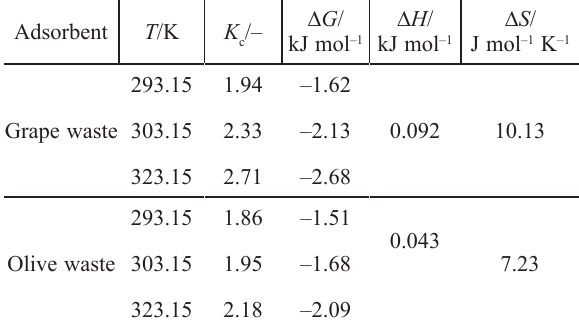
Table 4 – Thermodynamic parameters for the adsorption of Cr(VI) on grape and olive waste ∆ G / ∆ H / Adsorbent T /K K /– kJ mol –1 kJ mol c